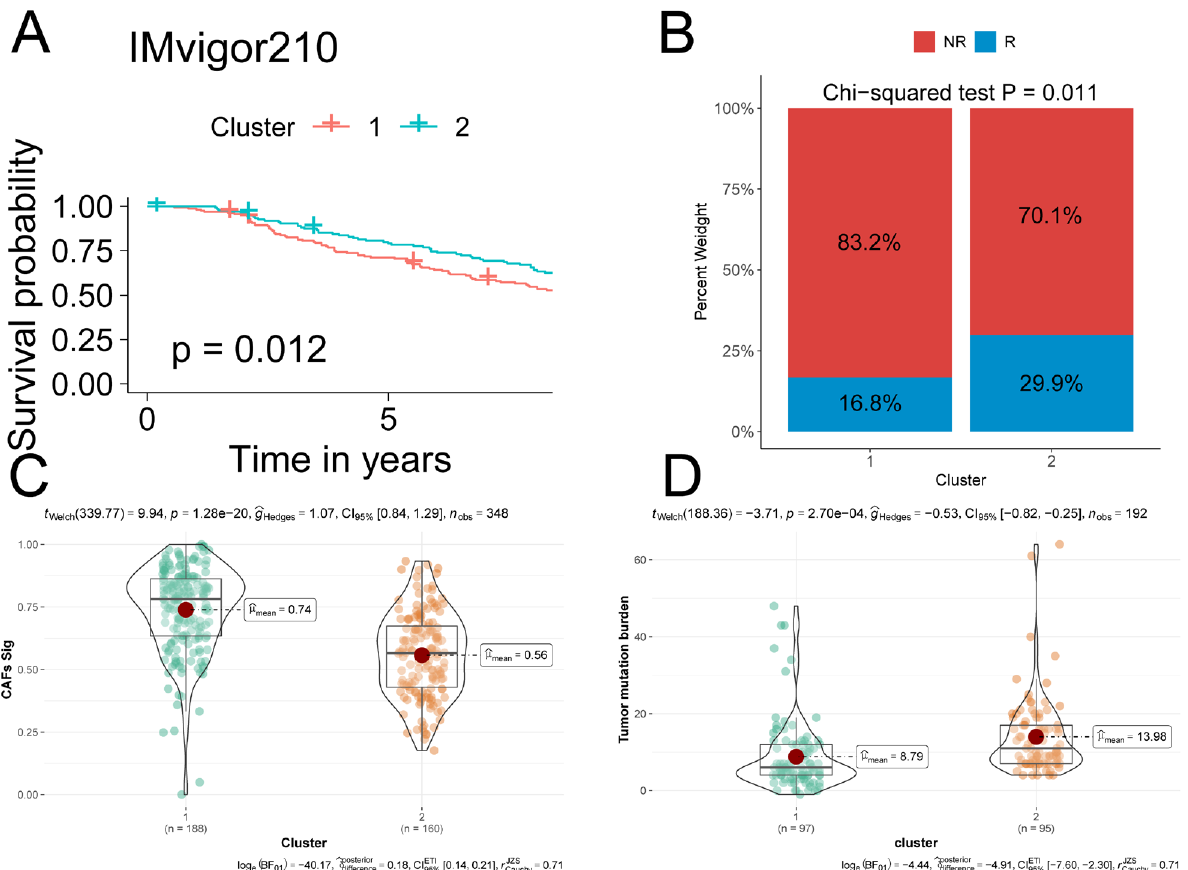
Figure 4. iCAF-related subtypes predicted prognosis and immunotherapeutic response in IMvigor210: ( A ) Two clusters were identified through iCAF-related signature-based consensus clus- tering. Patients in Cluster 1 were related to a poorer prognosis compared to those in Cluster 2. ( B )